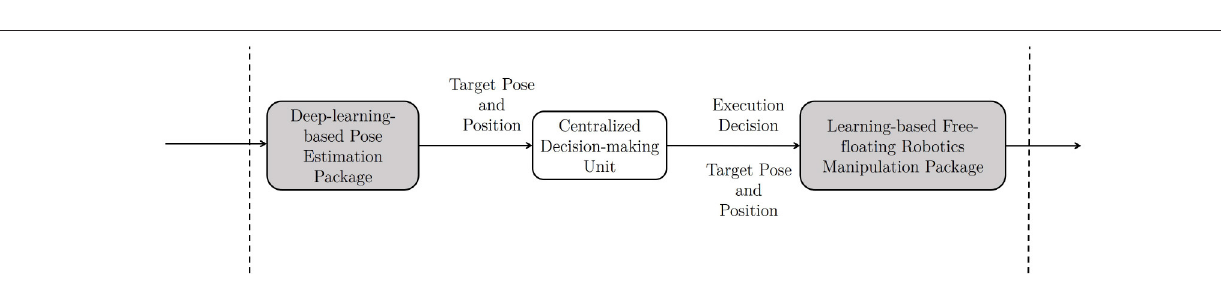
FIGURE 9 | Results from the trained model (both object detection and keypoint estimation) along with computed pose from PnP.